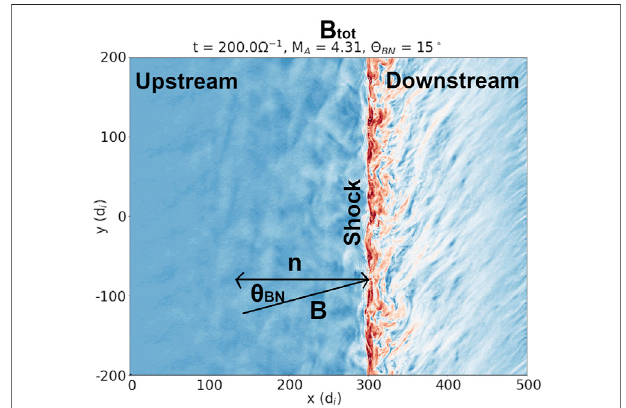
FIGURE 1 | An example of the output from the model with θ BN = 15 ° and